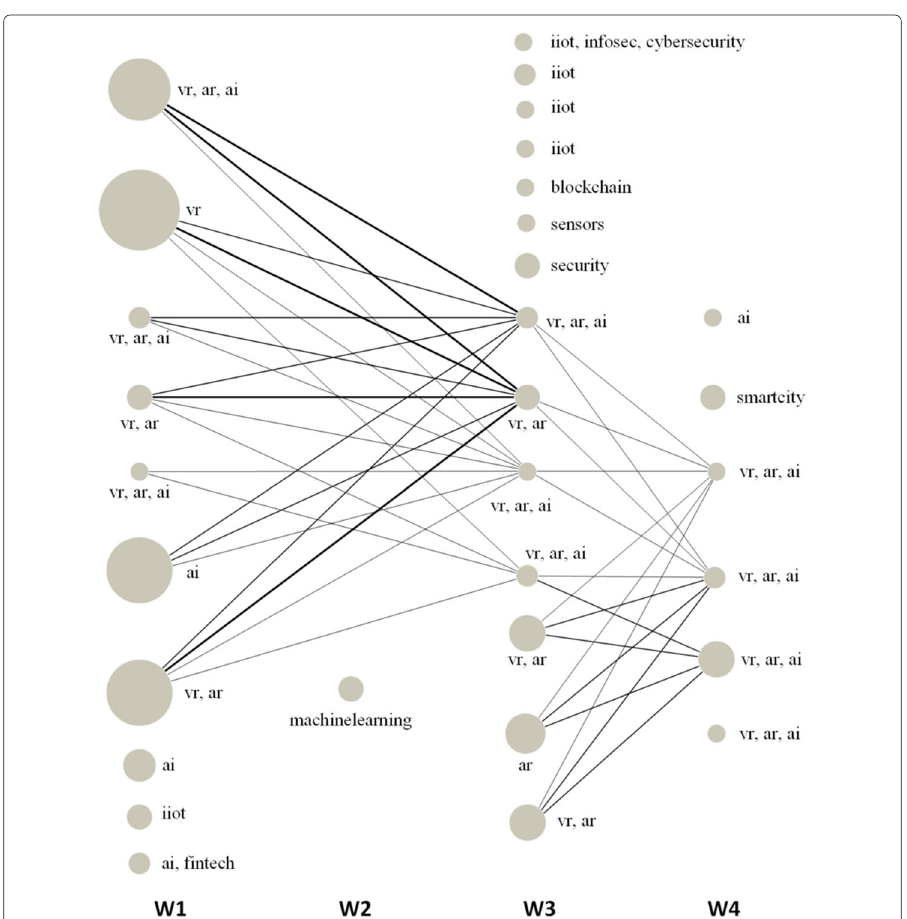
Fig. 11 Evolution of communities in the IoT space. The size of the communities is indicated by the size of the nodes — representing the number of actors — and the annotated hashtags. The thickness of the edges between two communities indicates the number of common actors between